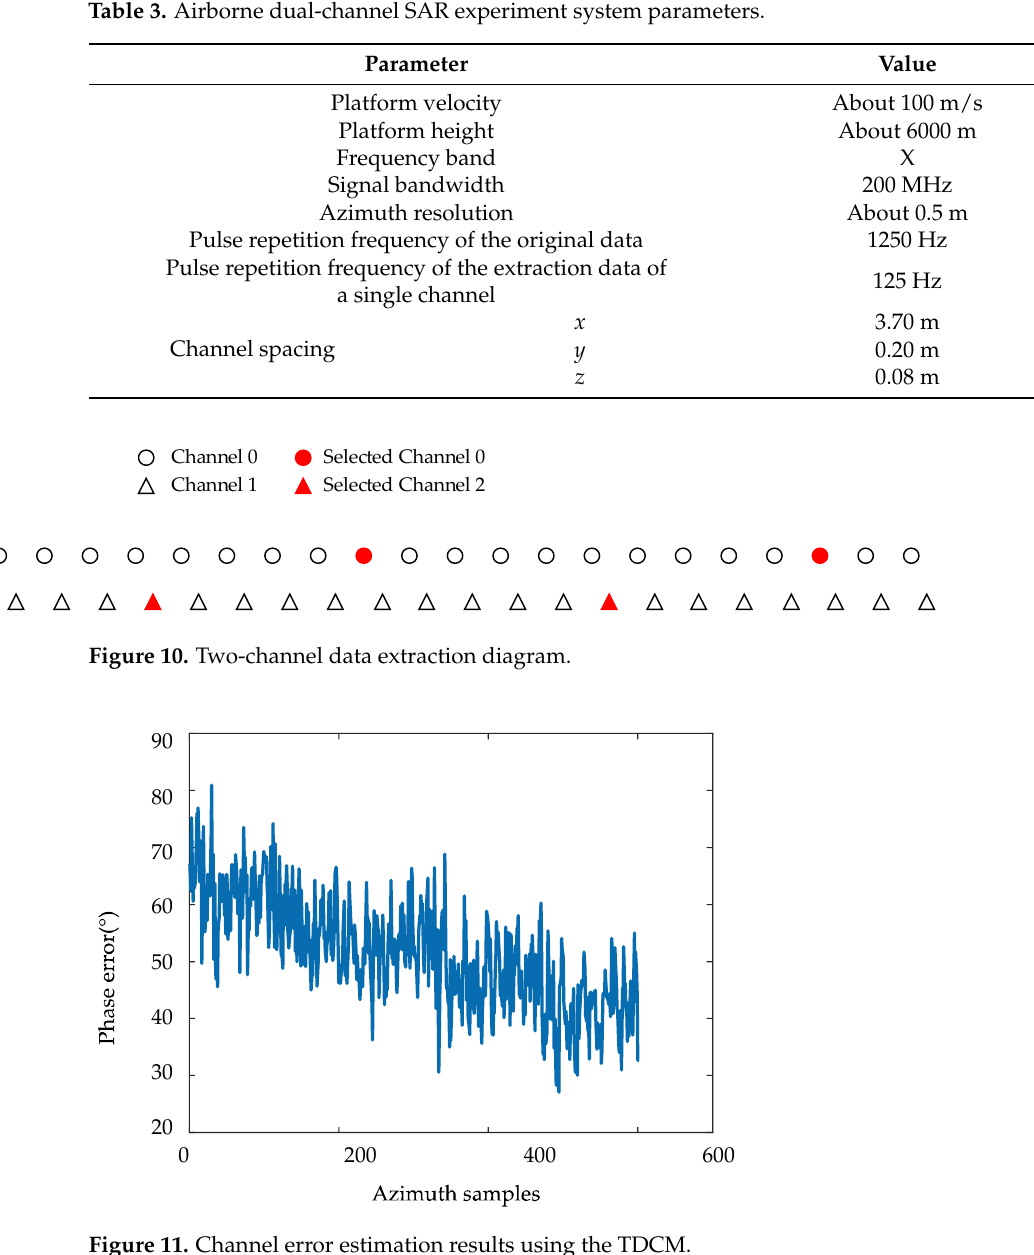
Figure 11. Channel error estimation results using the TDCM.